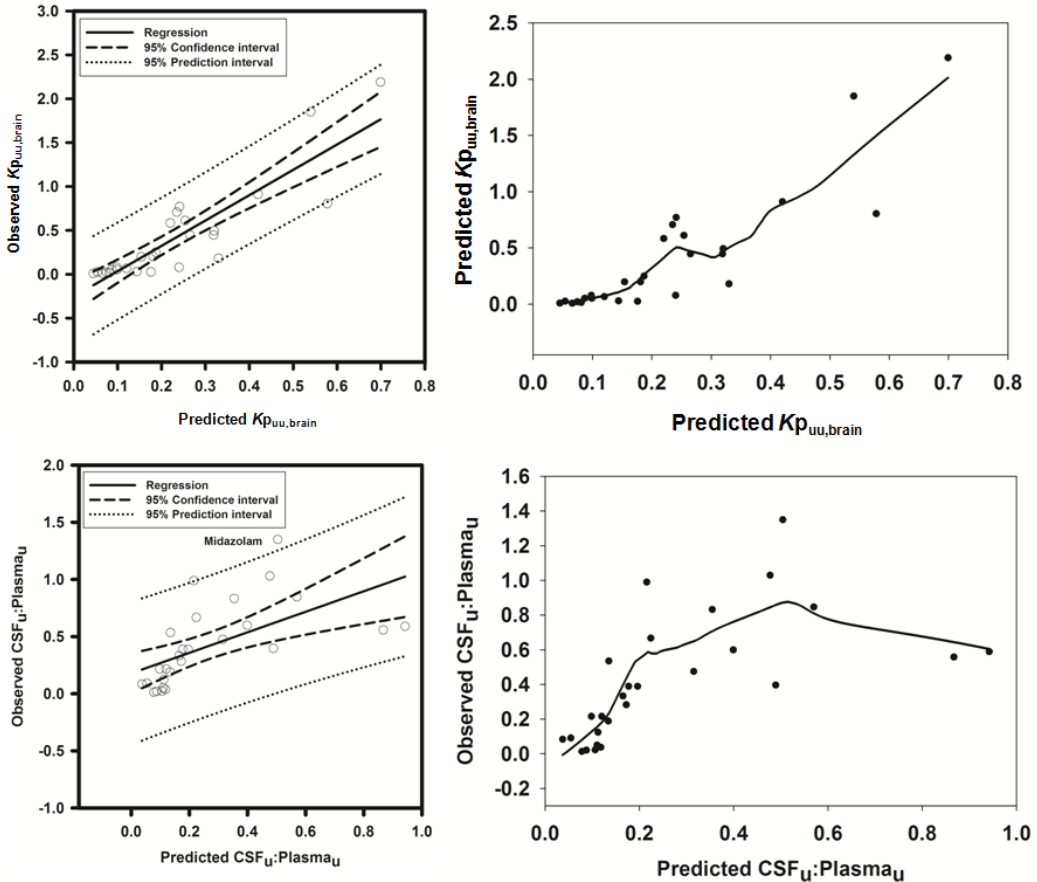
Figure S2. LOESS regression and confidence interval plots.